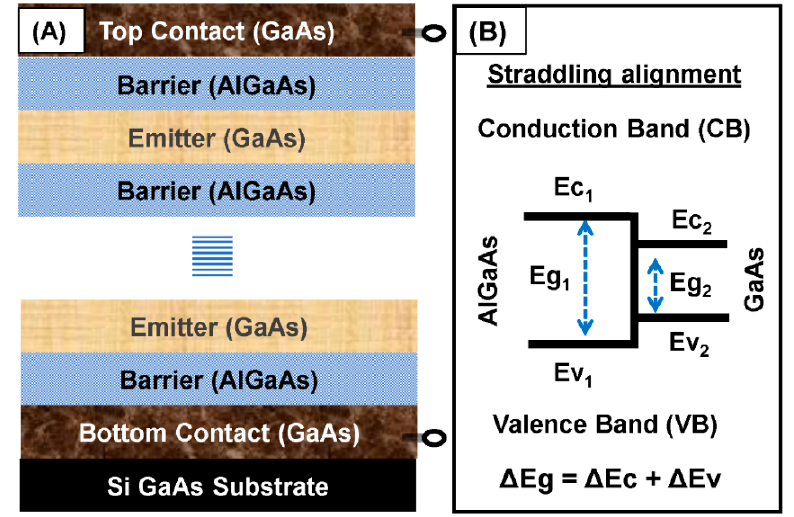
Figure 1. Typical architecture of a GaAs / AlGaAs heterostructure and the type depending on band alignments. ( A ) The combination of two dissimilar semiconductors in the heterostructure. The design is a p-GaAs / AlGaAs heterostructure and every layer of the emitter (p-type GaAs) is sandwiched between two layers of the barrier (AlGaAs). ( B ) Type-I heterostructure made of GaAs and AlGaAs. In such heterostructures, bandgap overlaps and ∆ E g = ∆ E c + ∆ E v.